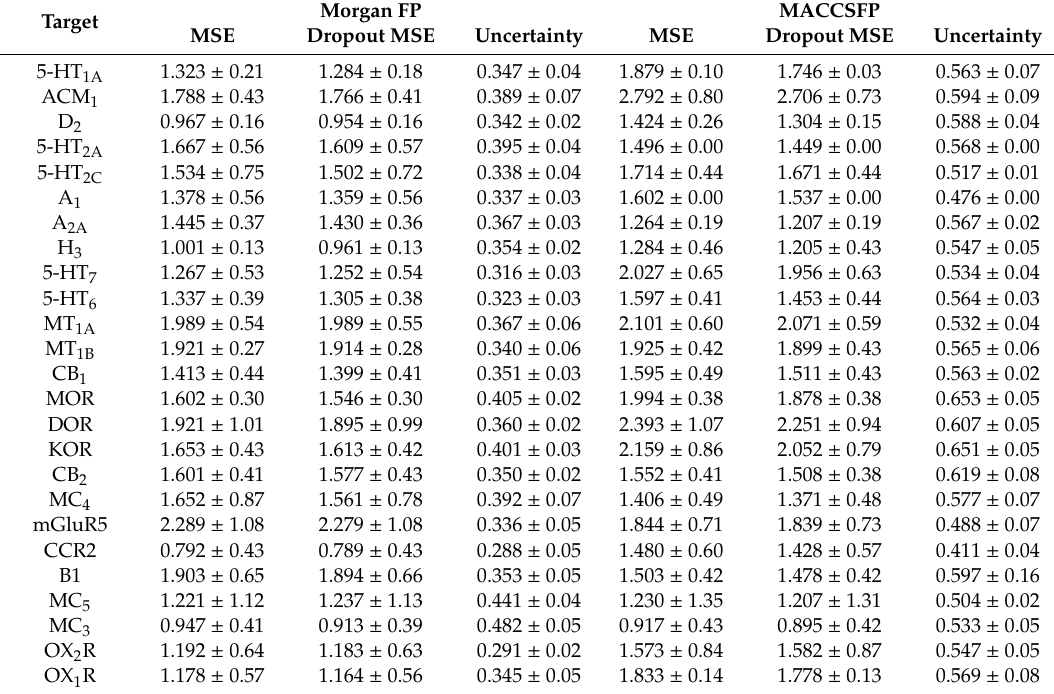
Table 2. Regression results obtained for